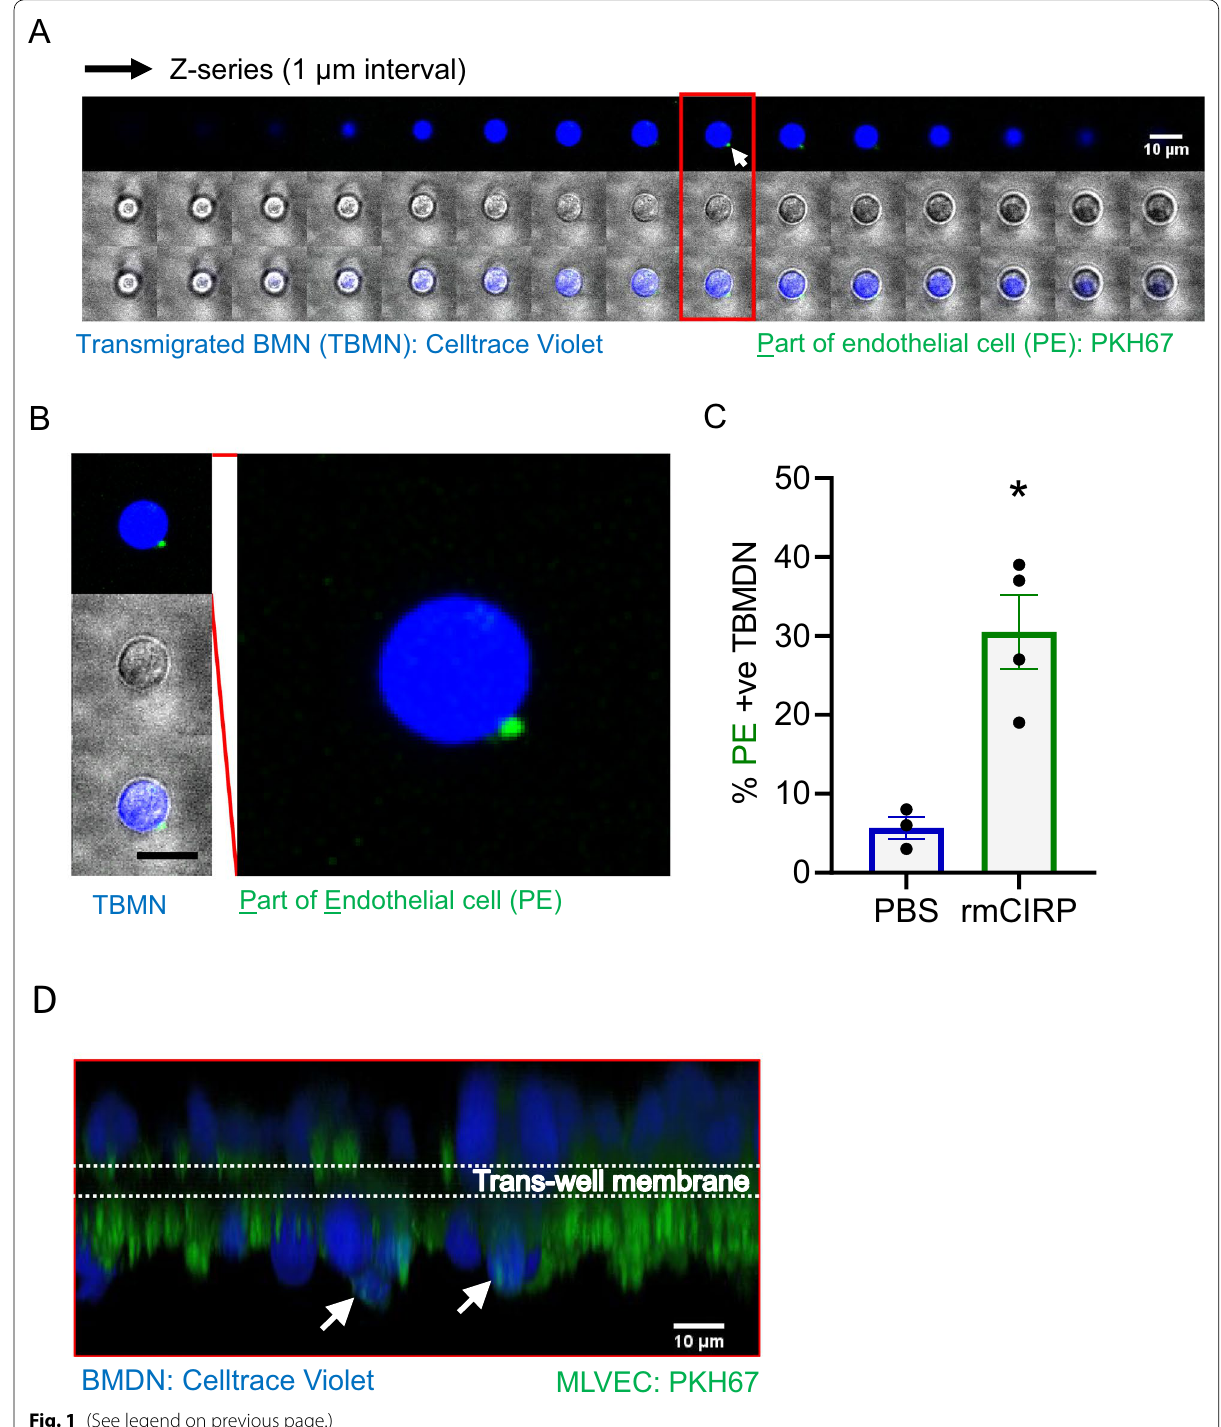
Fig. 1 (See legend on previous